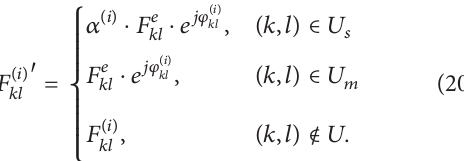
number to 5000 and 10000 for the two cases,